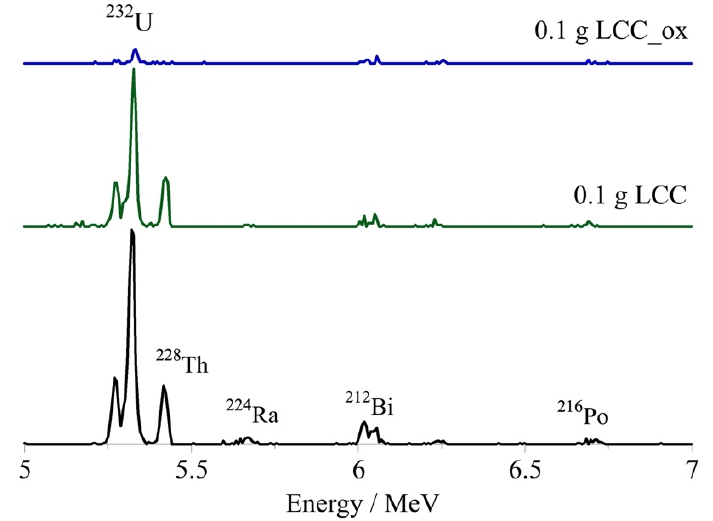
Figure 7. The alpha spectra of U-232-traced seawater solutions treated with 0.1 g of unmodified (LCC) and oxidized biochar (LCC_ox). [U-232] = 8.6 × 10 − 14 mol/L, pH 8.3 and ambient